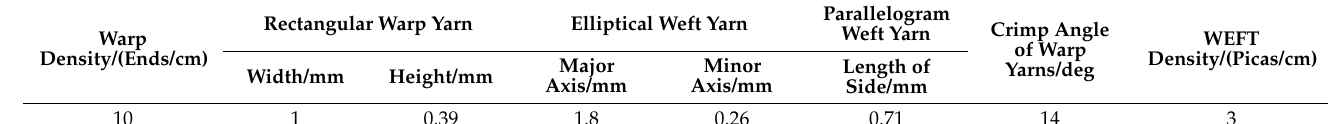
Figure 3. Geometry of 2.5D braided composite.